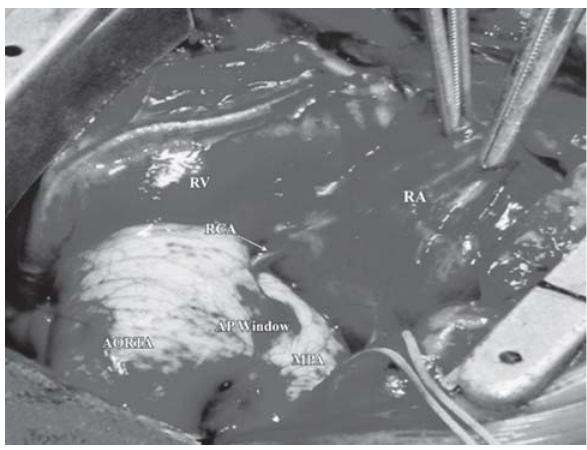
Fig. 1 – Intraoperative photograph showing D-Transposition of great arteries with an aortopulmonary window before surgical repair. Aorta was found to be anterior to the pulmonary artery with a large aortopulmonary window between them RV – Right ventricle, RA – Right atrium, MPA – Main pulmonary artery, RCA – Right coronary artery, AP Window - Aortopulmonary window